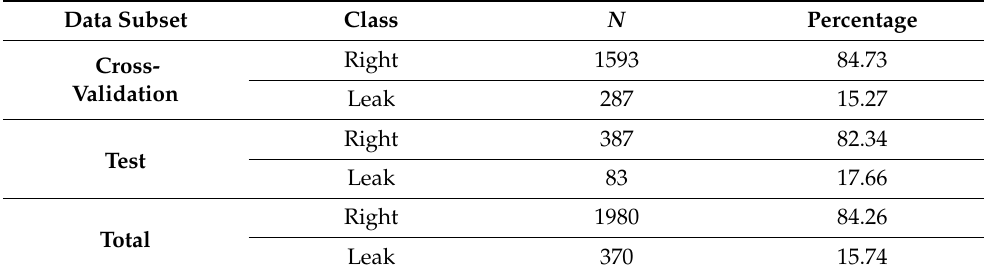
Table 1. Number of cases and percentage distribution of the classes for the subset of balloon-type data into which the initial dataset was subdivided.